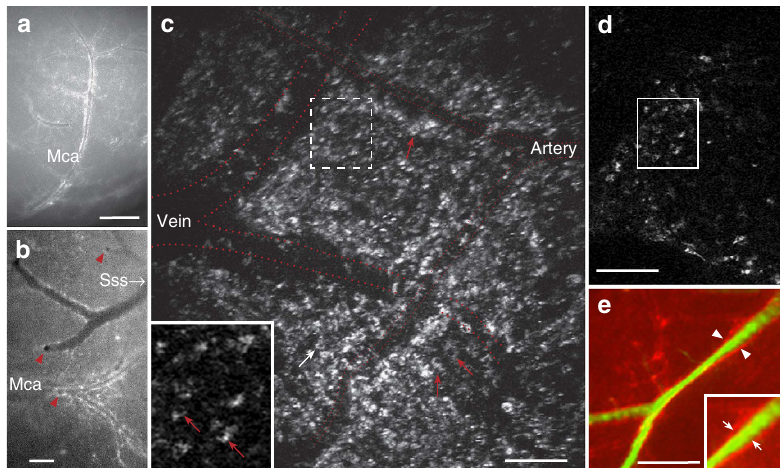
Figure 2 | Survey of HCAR1 in pia mater and at pial blood vessels supplying the brain. ( a , b ) Surface views of the brain of a mRFP-HCAR1 reporter mouse. ( a ) Right arteria cerebri media (Mca), lateral view. Scale bar, 900 m m. ( b ) Branch of left Mca, top view, and vein draining into the superior sinus sagittalis (Sss). Branches penetrating the brain parenchyma are seen as black holes in b (red arrowheads). mRFP fluorescence appears enriched along blood vessels. Scale bar, 300 m m. ( c , d ) Two-photon imaging of pia mater in a live and walking mRFP-HCAR1 reporter mouse showing leptomeningeal cells (arrows) in the vicinity of two pial blood vessels (approximate vessel positions indicated by red dotted lines). ( c ) Stack of superimposed optical sections. Scale bars, 100 m m. ( d ) Single optical section (1 m m); frame shown is magnified as inset in c ; stippled frame in c indicates) position of frame in stack. ( e ) Surface view of the cortex from mRFP-HCAR1 reporter mouse showing fluorescent pial vessel outline (arrowheads) and lumen (green) after retrograde injection of FITC-dextran agarose in the v. jugularis. Scale bar, 300 m m. Inset: magnified view showing space between green and red corresponding to vessel wall (small